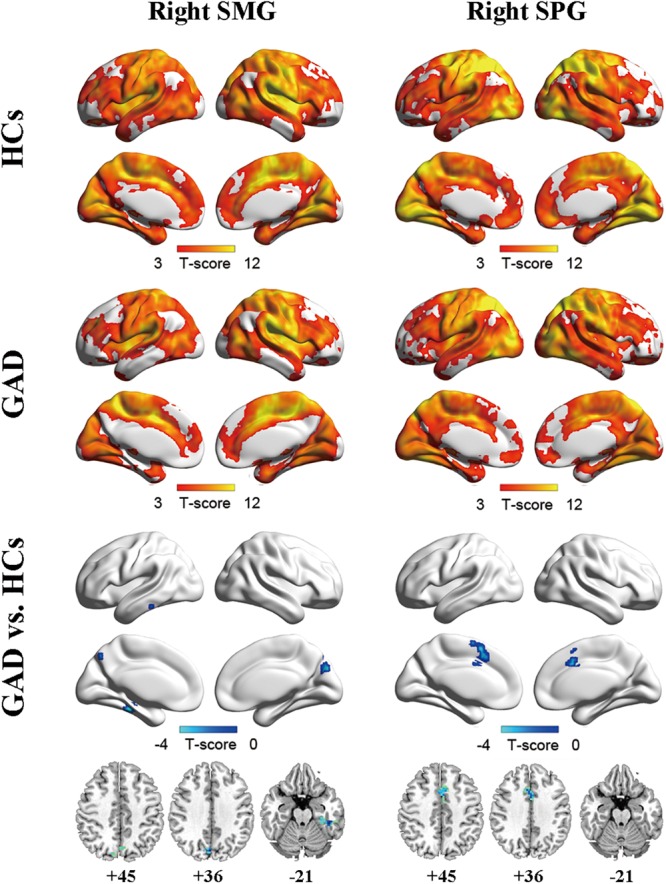
Functional connectivity maps for right SMG (left column) and right SPG (right column) of the HCs group (upper), the GAD patient group (middle), and between-group differences (lower). The significance threshold was set at p < 0.001 with cluster size of 48 voxels for right SMG as ROI and 50 voxels for right SPG as ROI, corresponding to a corrected p < 0.01. HCs, healthy controls; GAD, generalized anxiety disorder; SMG, supramarginal gyrus; SPG, superior parietal gyrus.